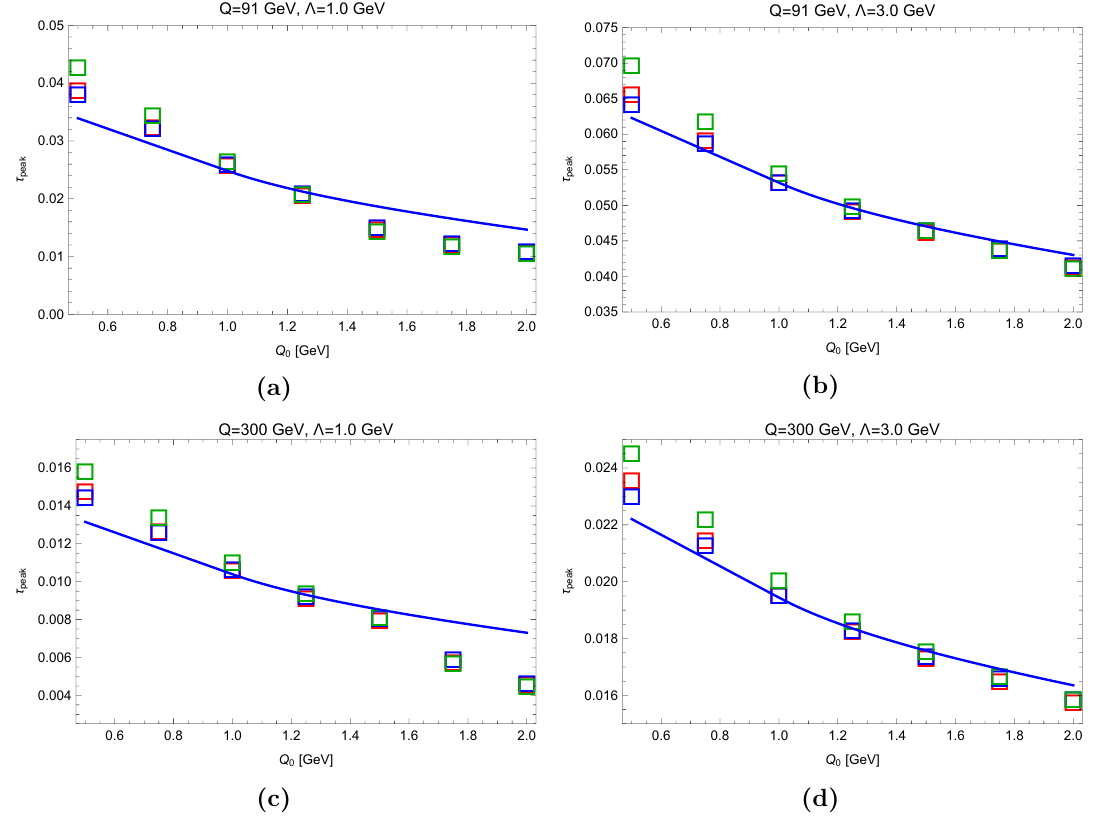
Figure 10. Peak position (cid:28) peak at the parton level obtained from Herwig 7 as a function of the shower cut Q 0 and including a smearing with (cid:3) = 1 GeV (left panels) and (cid:3) = 3 GeV (right panels) for massless quarks and Q = 91 GeV (upper panels) and Q = 300 GeV (lower panels). Displayed are the results from the full simulation (red squares), with gluon splitting turned o(cid:11), but angular ordering turned on (blue squares) and with gluon splitting and angular ordering both turned o(cid:11) (green squares). The blue solid line is the analytic prediction of eq. (7.1) taking the Herwig 7 result for Q 0 = 1 : 25 GeV as the reference. 0